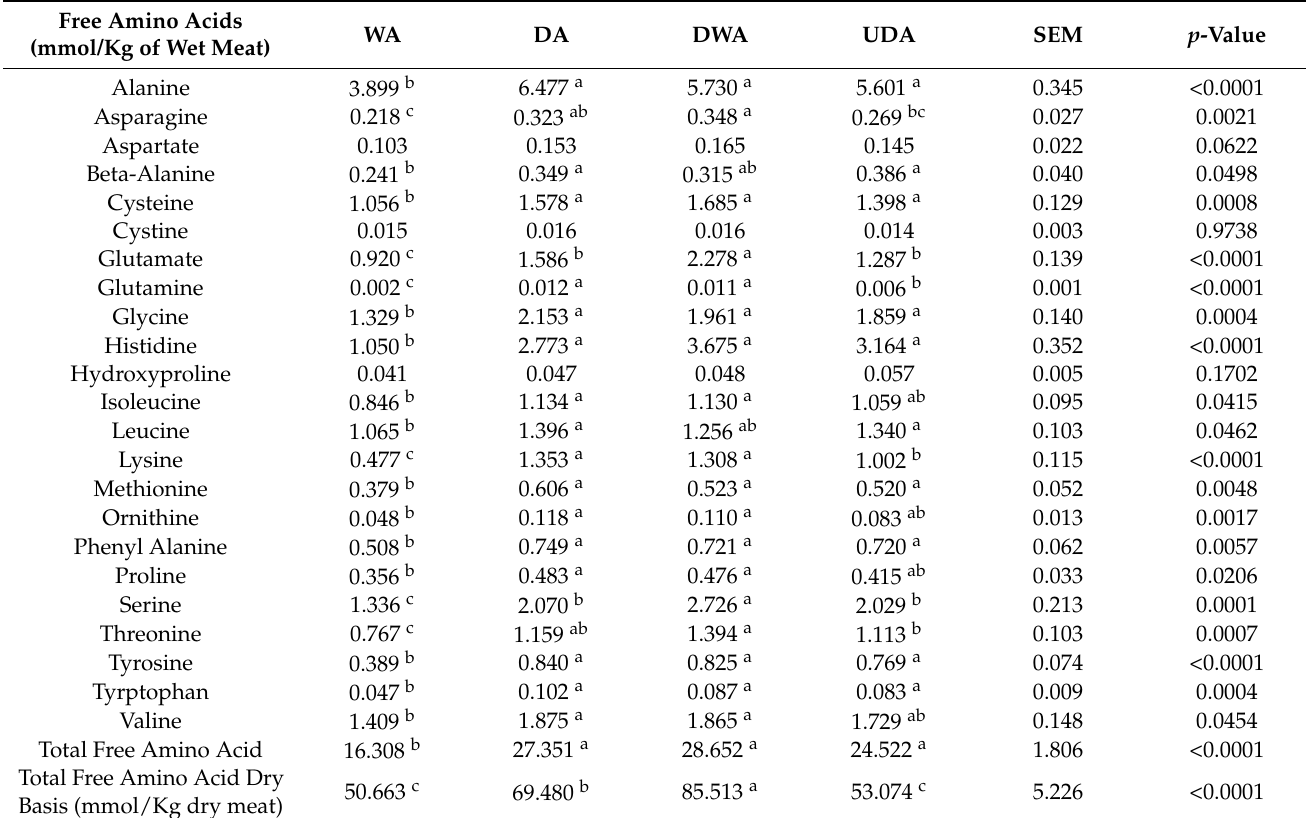
Table 1. Effect of different aging methods on the free amino acid contents of cull cow beef loins ( M. longissimus lumborum ) after 28 days of